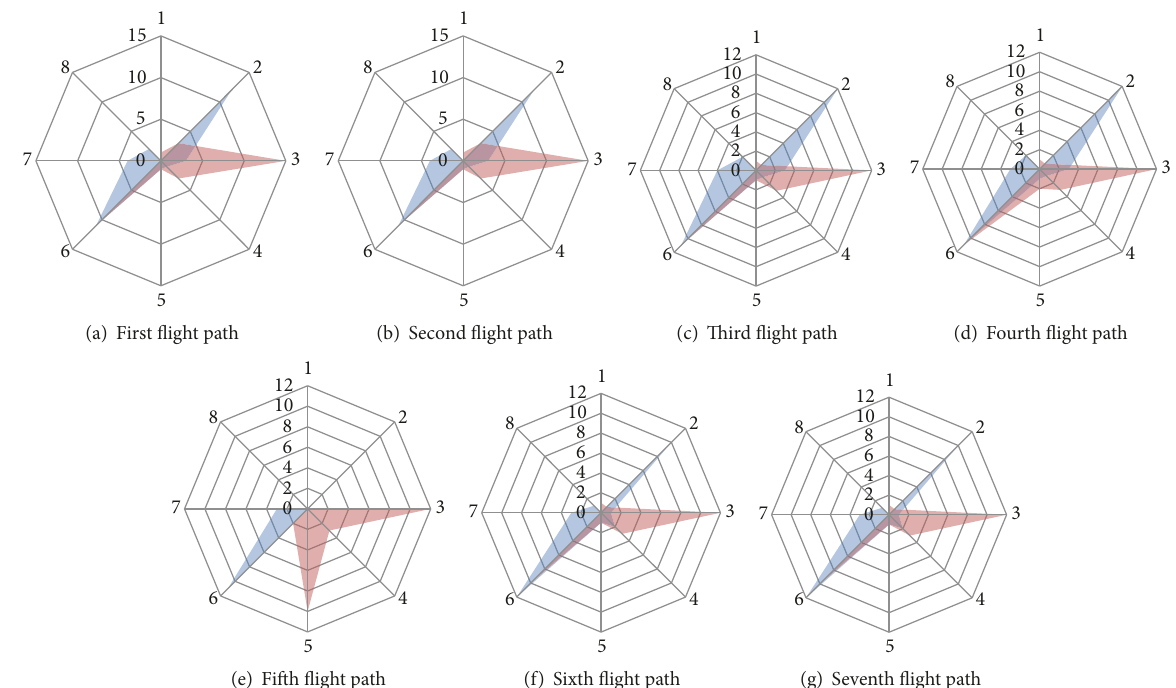
Figure 13: Number of aircraft waiting along each corridor in various flight paths.